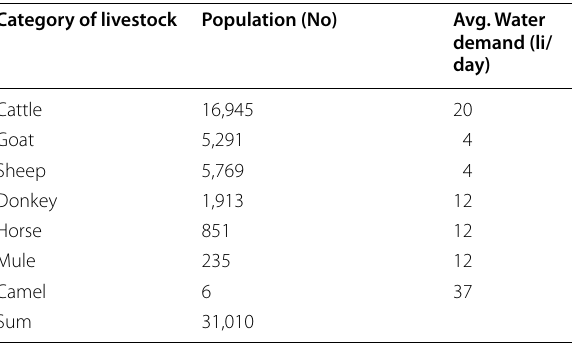
Table 7 Livestock types and population in the Arata catchment